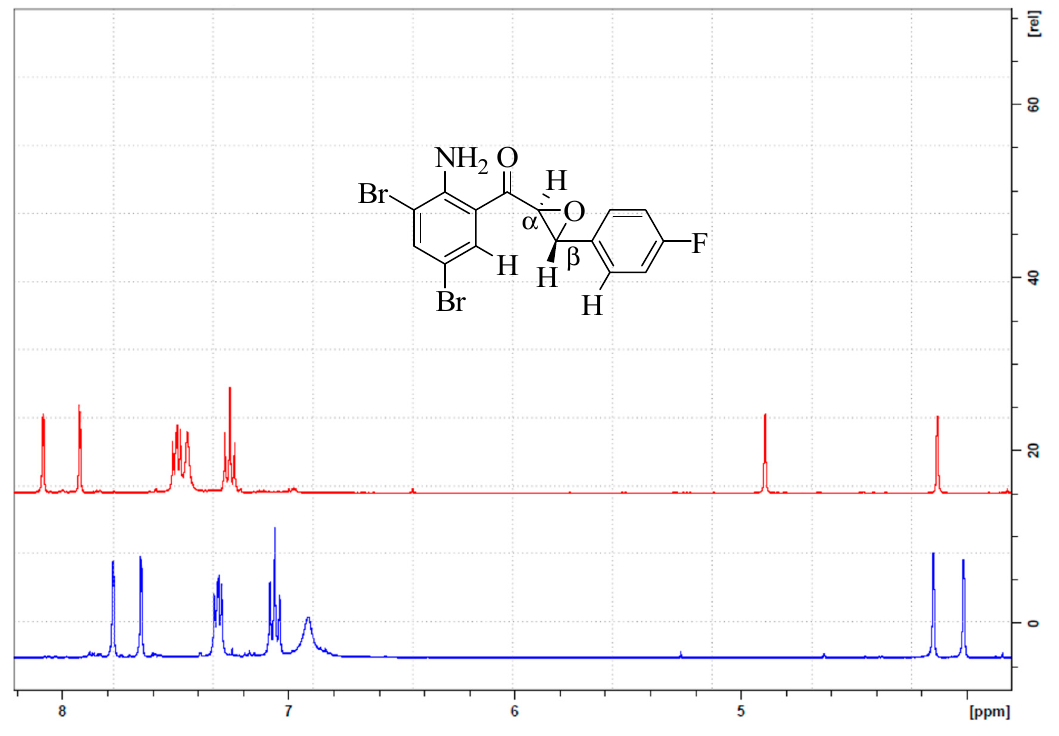
Figure 1. 1 H-NMR spectra of 2b in CDCl 3 (blue) and DMSO- d 6 (red) at 400 MHz.